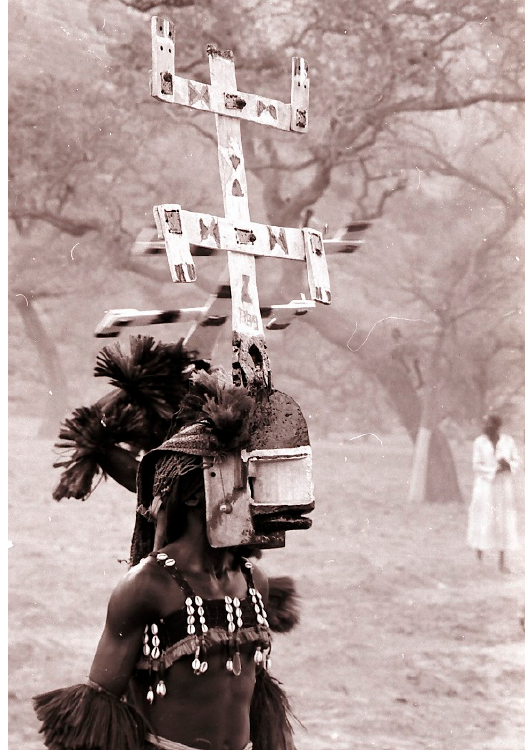
Figure 8. Another kanaga of 1989. Note the year on the base of the headpiece.